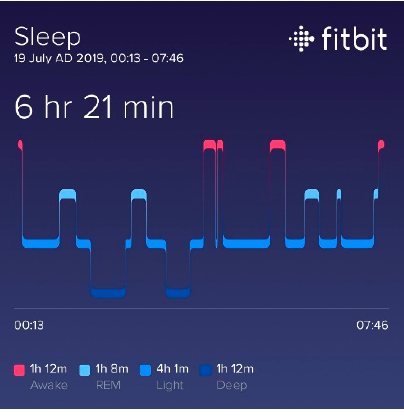
Figure A13. Hokkaido, Japan.